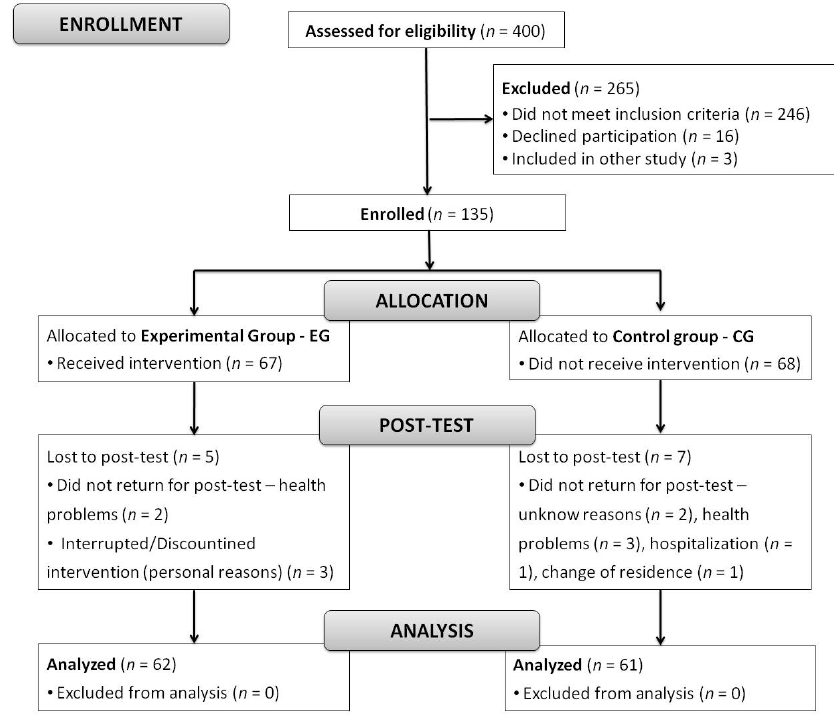
Figure 1. Consort Figure 1. Consort diagram.